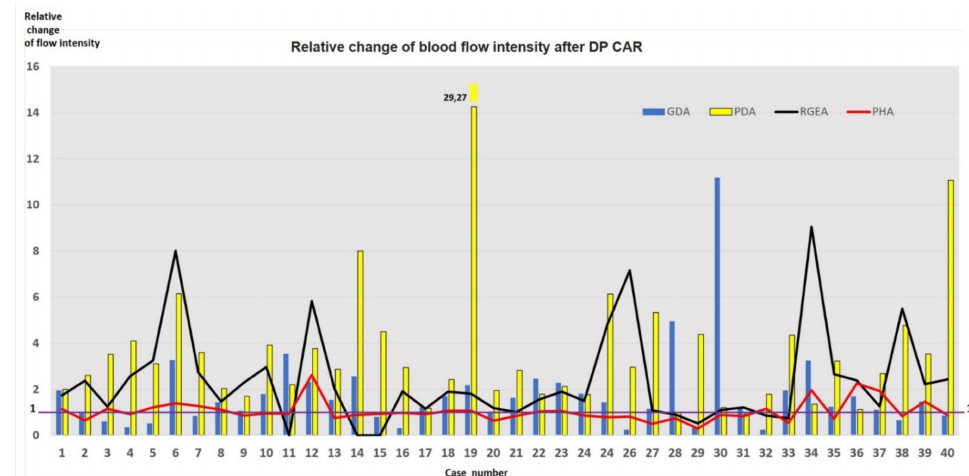
Figure 4. Calculated relative change of blood flow intensity (volumetric flow rate in mL/min, Q) after DP CAR. As shown, the blood flow intensity can increase 12–30 times, which underlines the adaptive ability of the pancreatoduodenal arcade participators and the hemodynamic benefit of the sole collateral instead of two or more. The relative change of the blood flow intensity values for RGEA and PHA presented here are associated with discrete cases (samples). Straight lines segments connecting these data points were used in the graph in place of bar charts to illustrate the dispersion with regards to the baseline, i.e., the 1.0